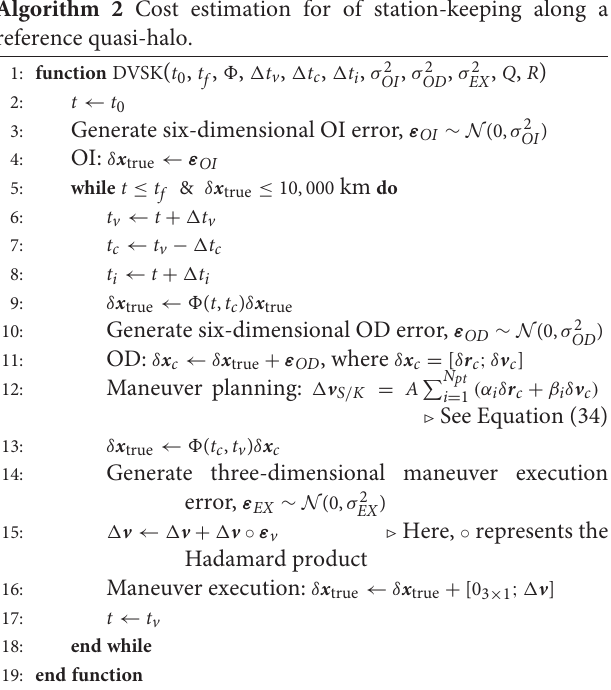
Algorithm 2 Cost estimation for of station-keeping along a reference quasi-halo.